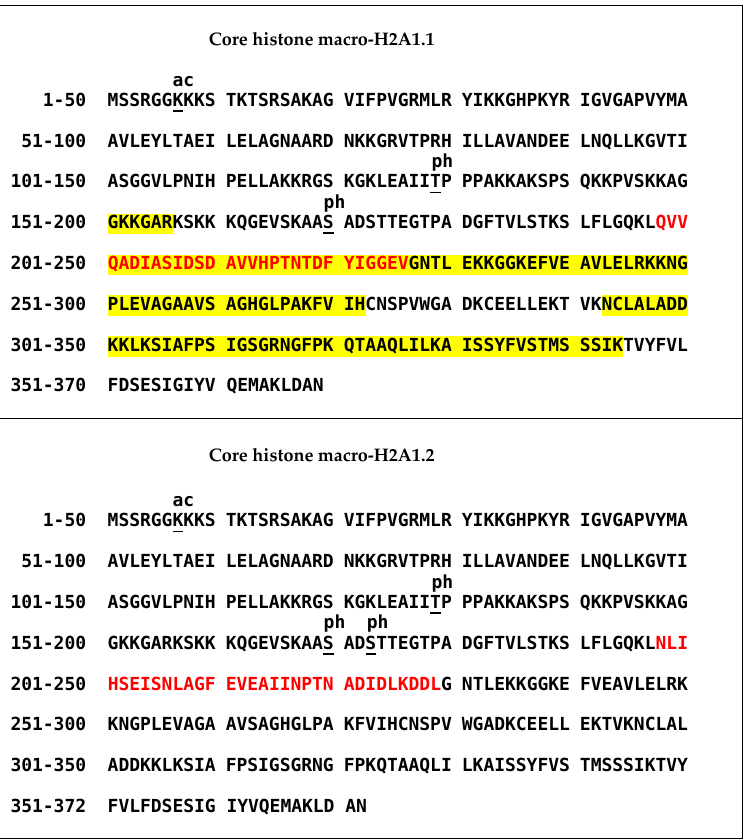
Figure 3. Characterization of macroH2A1.1 and macroH2A1.2 protein isoforms in HepG2 cells using LC-MS/MS. More than 75% of sequence coverage (indicated in yellow) was obtained for both isoforms using merged data from trypsin digestion combined with chemical derivatization of lysines. Only highly confident peptides identified using a fixed-value PSM validator node with Mascot parameters set to Rank 1, expectation value < 0.01, and ion score ≥ 30 were considered. Identified PTMs, including phosphorylation (ph) and acetylation (ac) are indicated. Quantified PTMs are colored in purple. Peptide carrying S173ph was identified only in a single replicate of macroH2A1.2 and could not have been quantified due to a very low intensity across the sample set. The amino acid sequence corresponding to the isoform ‐ specific region is shown in red.